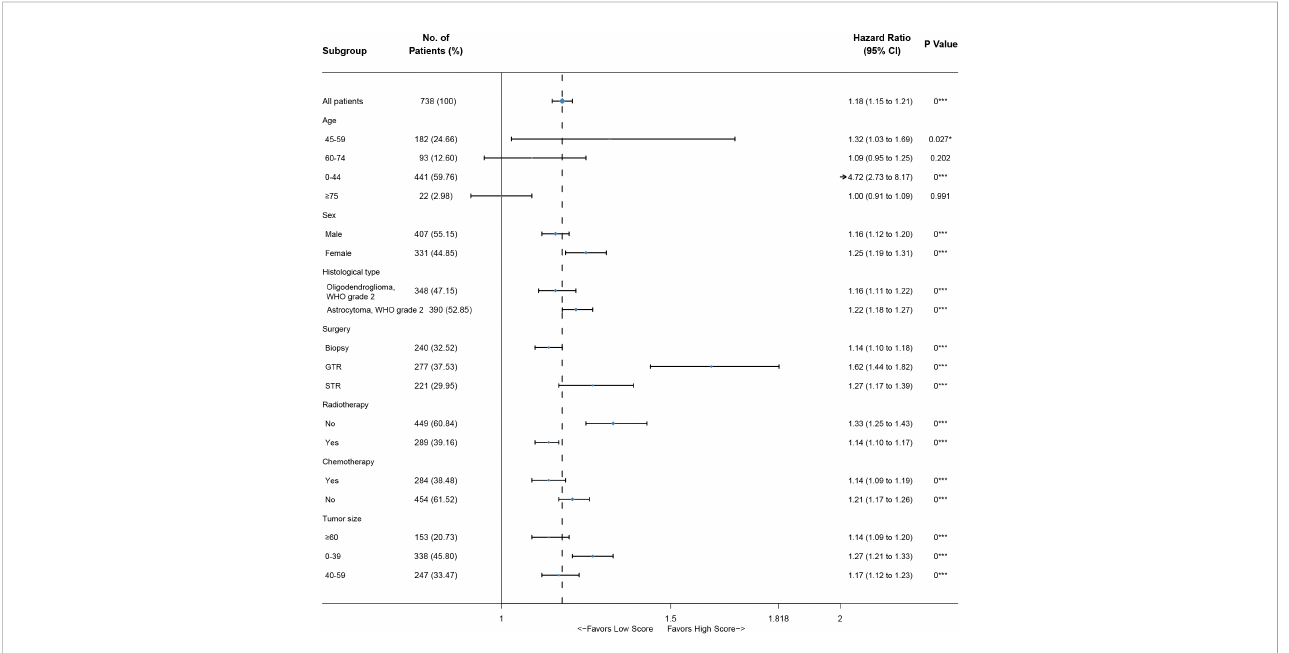
FIGURE 6 Subgroup analysis of the validation